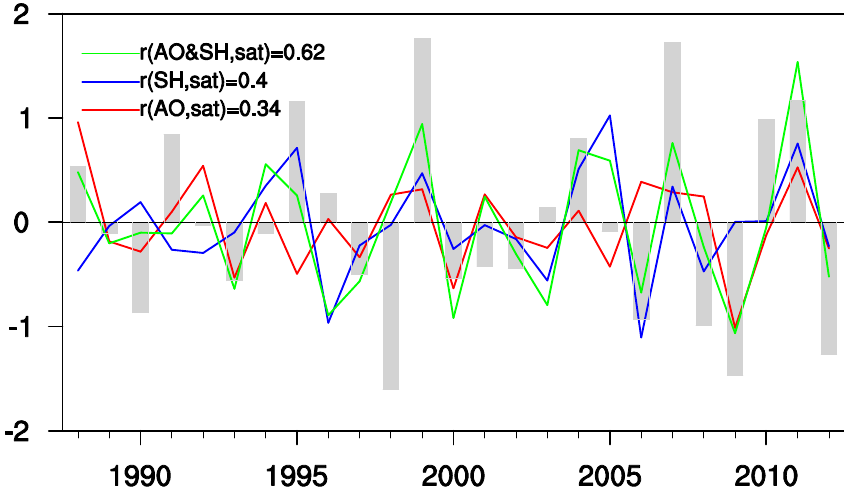
Figure 8. Normalized PC time series corresponding to EOF1 of interannual variation of the winter southeast Asian SAT during 1988–2012 (bars). Cross-validated hindcasts of the PC1 time series via empirical models using the winter SH index alone (blue line), using the winter AO index alone (red line), and using both the winter SH and AO indices (green line).